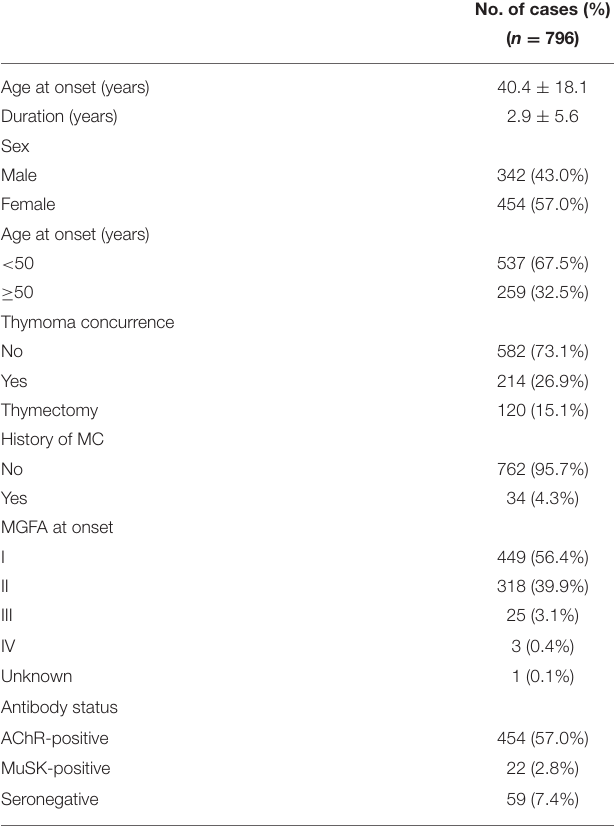
TABLE 1 | Clinical characteristics of patients with MG.